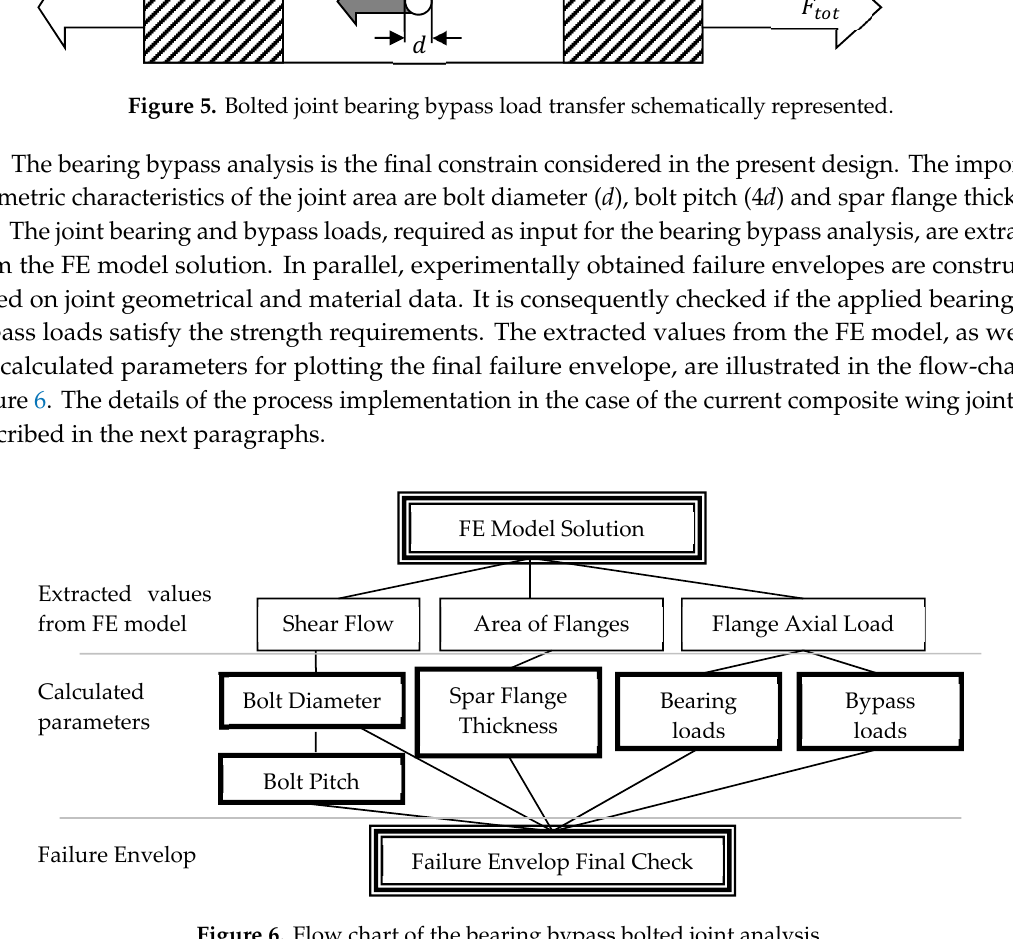
Figure 6. Flow chart of the bearing bypass bolted joint analysis.